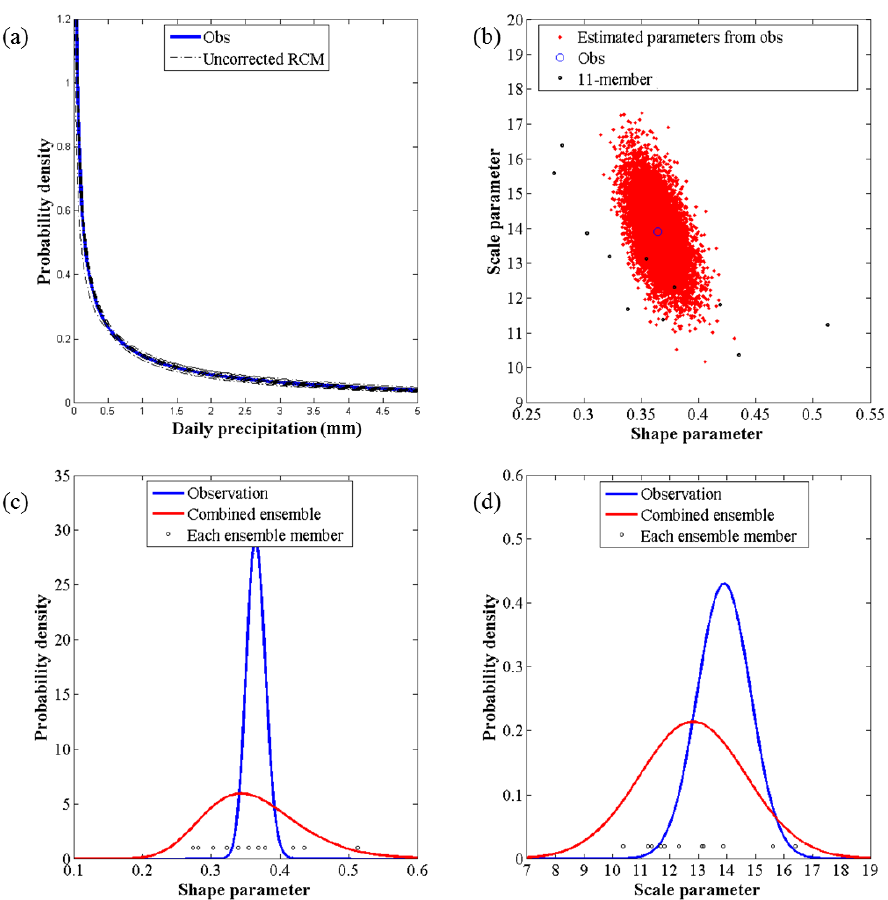
Figure 7. Parameter distributions of the observation and 11 members: (a) probability density function of the observed and 11-member precipitation time series before bias correction; (b) scatter plot between shape and scale parameters of the observed and bias uncorrected precipitation; (c–d) probability density functions of shape and scale parameters for the observed and bias uncorrected precipitation.